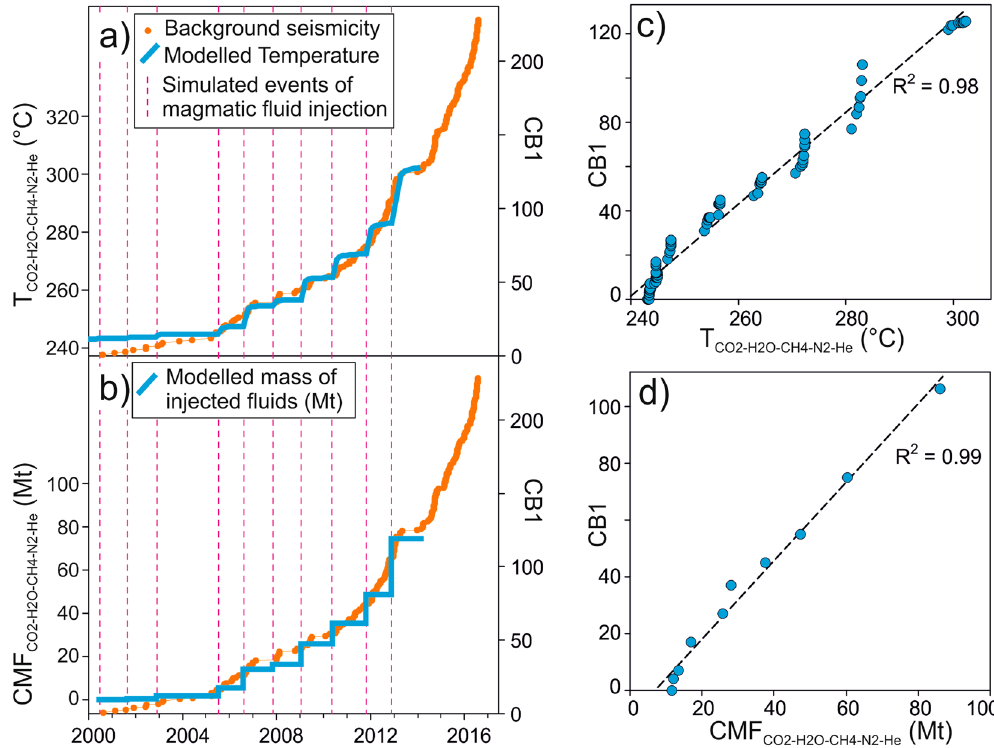
Figure 6. Background seismicity (CB1, see the text) compared with simulation results. ( a ) Chronogram of the cumulative background seismicity (orange dots) and the simulated temperature of the volume of rocks above the magmatic fluid injection zone (T CO2-H2O-CH4-N2-He °C; see Fig. 5a). The vertical magenta dashed lines indicate the time of the simulated episodes of magmatic fluid injection; ( b ) chronogram of the cumulative background seismicity (orange dots) and the cumulative mass of magmatic fluids injected into the hydrothermal system during the simulation (CMF CO2-H2O-CH4-N2-He ); ( c ) binary plot of CB1 vs T CO2-H2O-CH4-N2-He ; ( d ) binary plot of CB1 vs CMF CO2-H2O-CH4-N2-He